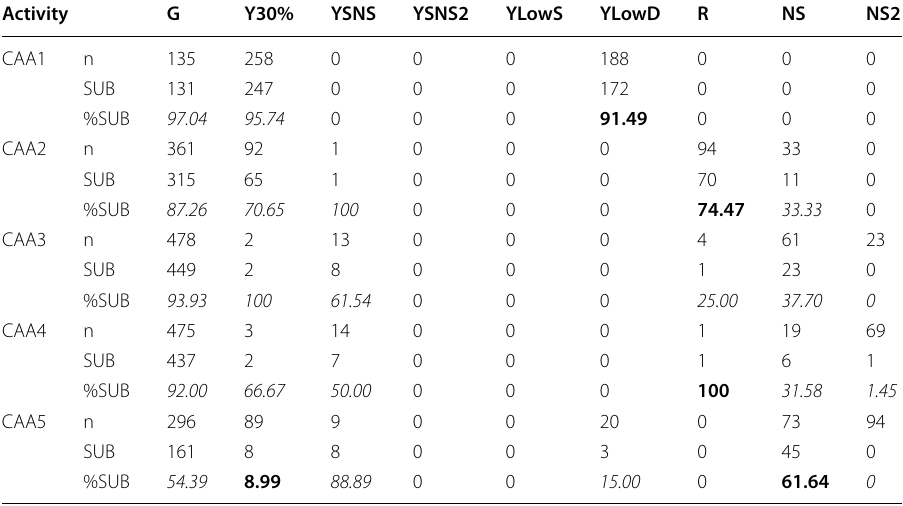
Table 4 Performance of the risk‑level identification on semester pilot